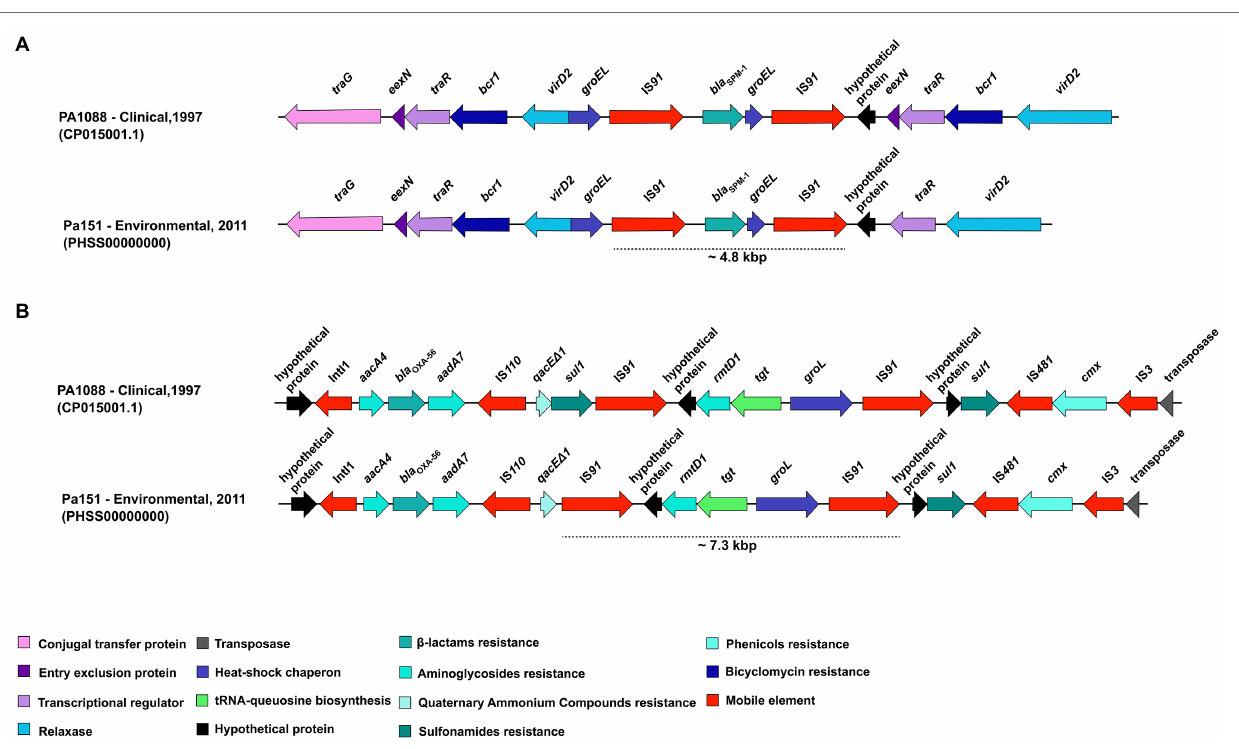
FIGURE 5 | Overall comparison of genetic context of bla SPM-1 and rmtD1 genes carried by clinical and environmental P. aeruginosa strains belonging to ST277. (A) The bla SPM-1 was flanked by a ~4.8 kbp region composed of IS 91 - bla SPM-1 - groEL -IS 91 . (B) The rmtD1 was flanked by a ~7.3 kbp region composed of the IS 91 - rmtD1 - tgt - groEL -IS 91 . In addition, aacA4 , aadA7 , bla OXA-56 , qacE Δ 1 , sul1, and cmx resistance genes were also identified along with genes encoding for hypothetical proteins, transposase; as well as IS 110 , IS 481 , and IS 3 mobile genetics